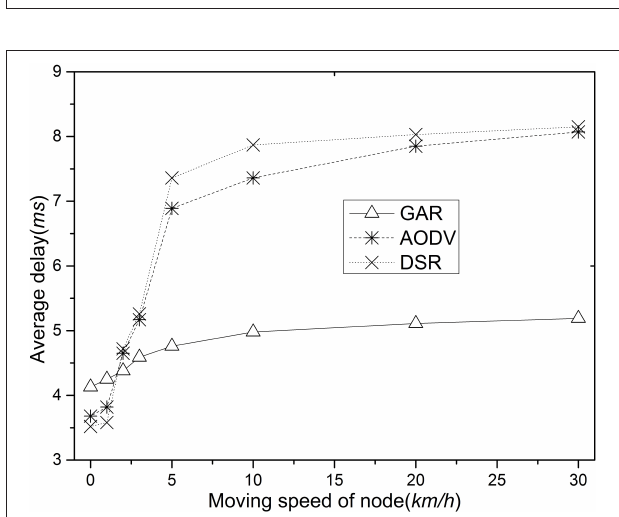
FIGURE 5 | Comparison of average delay as node speed